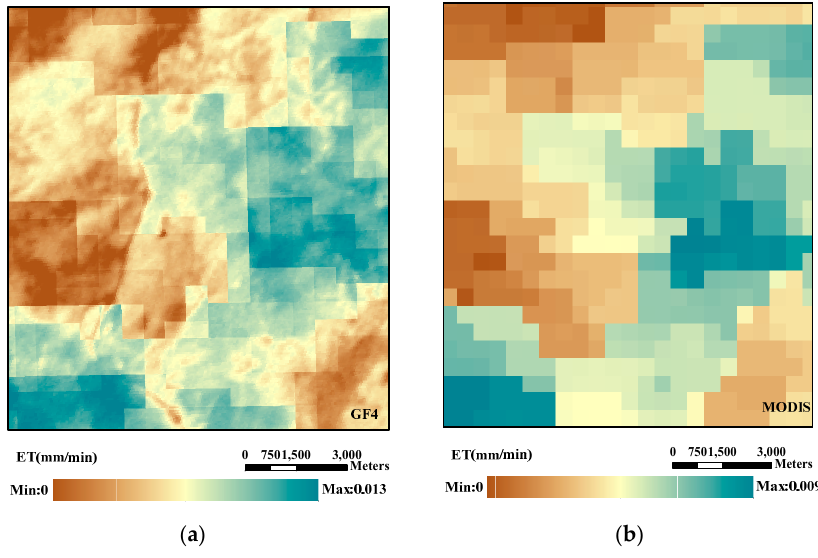
Figure 3. ET of GF-4 at 11:36( a ) and ET of MODIS at 11:35 ( b ) in area CF.